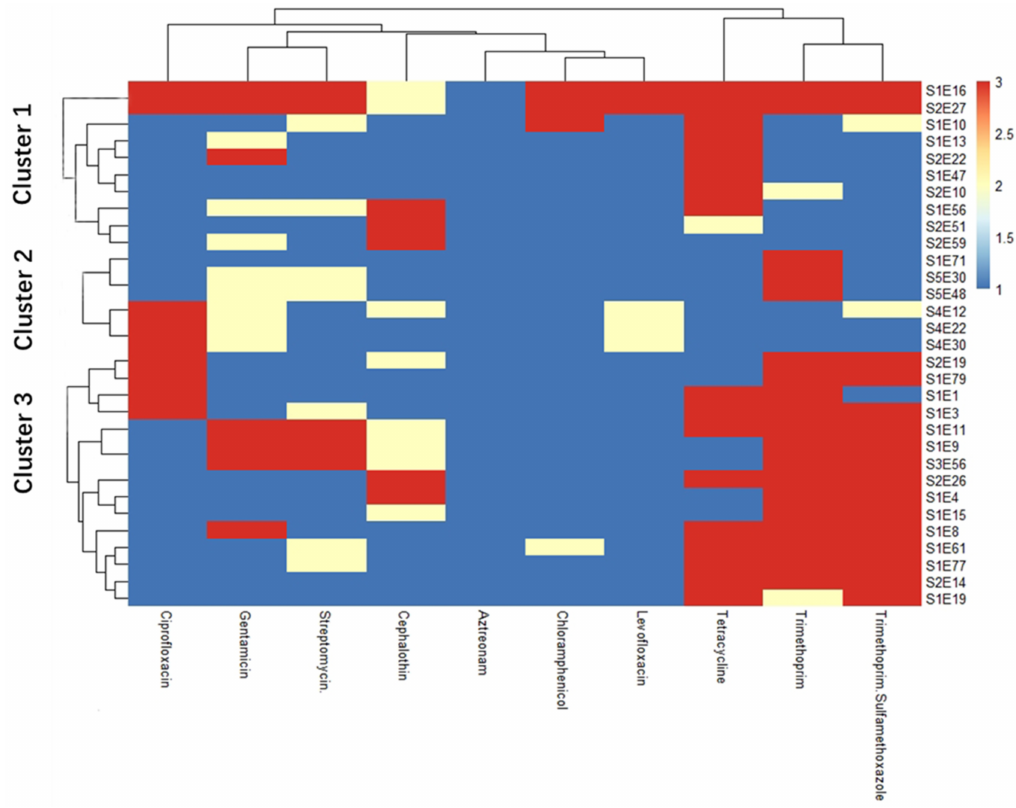
Figure 3. Heatmap cluster analysis of E. coli isolates’ antibiogram profiles. Color interpretation, blue (1): susceptible, yellow (2): intermediate, and red (3):